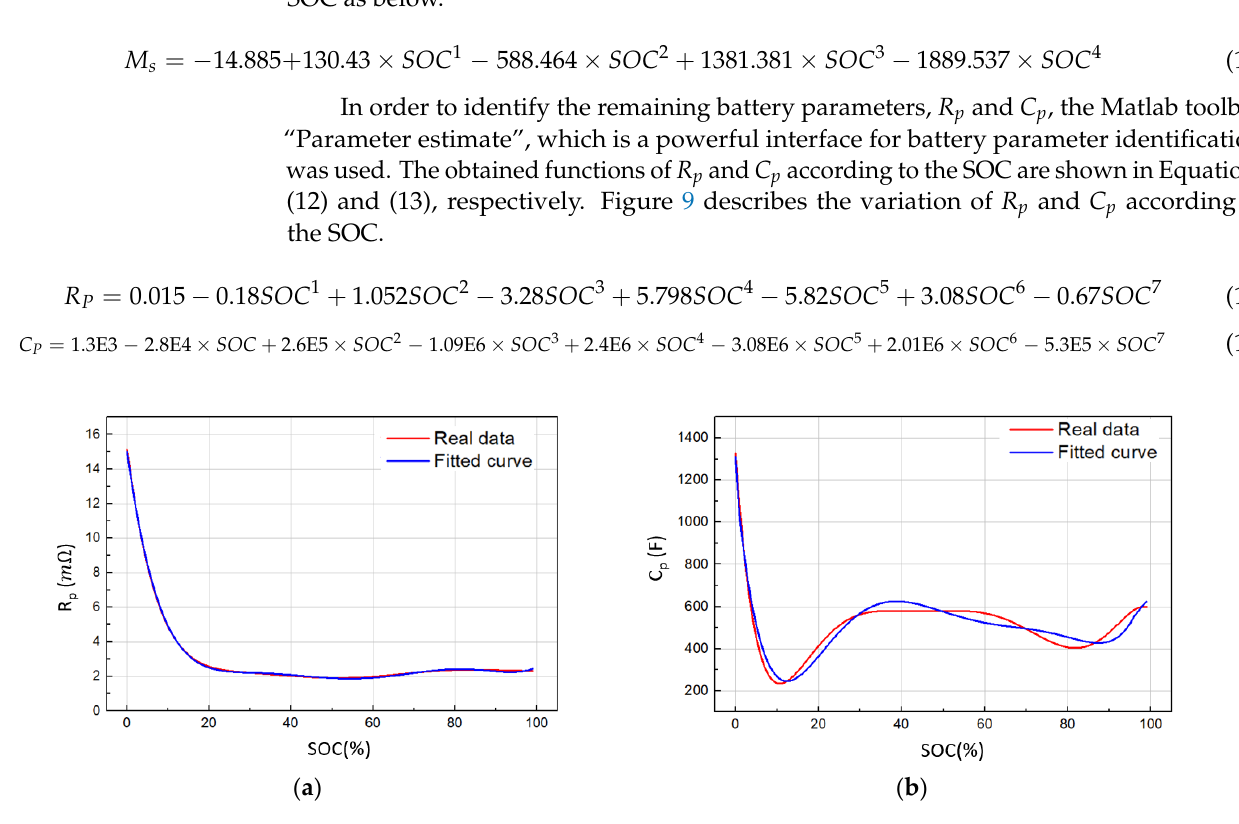
Figure 9. Variation of Rp and Cp according to SOC: ( a ) Rp ; and ( b ) Cp .